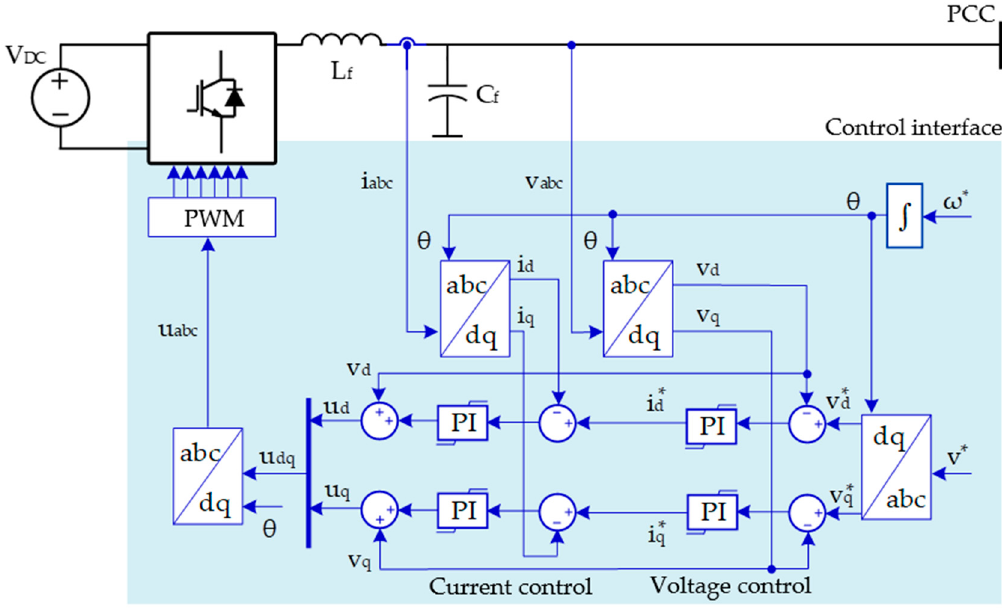
Figure 9. Basic implementation of grid-forming converter control according to [33].